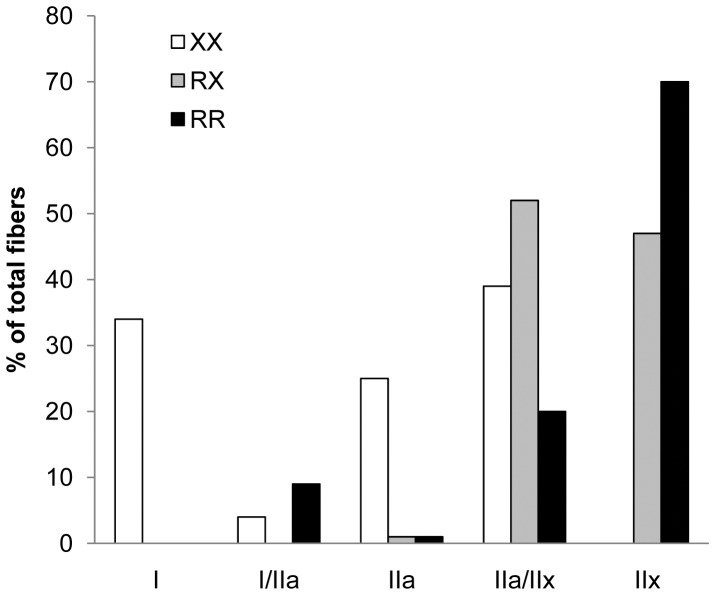
MHC isoform profiles of single fibers from the three SCI subjects.